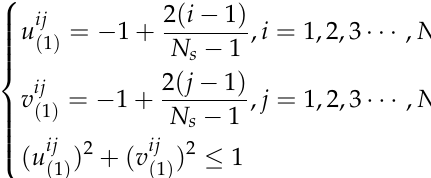
is the m th sampling point of the n th ( n )